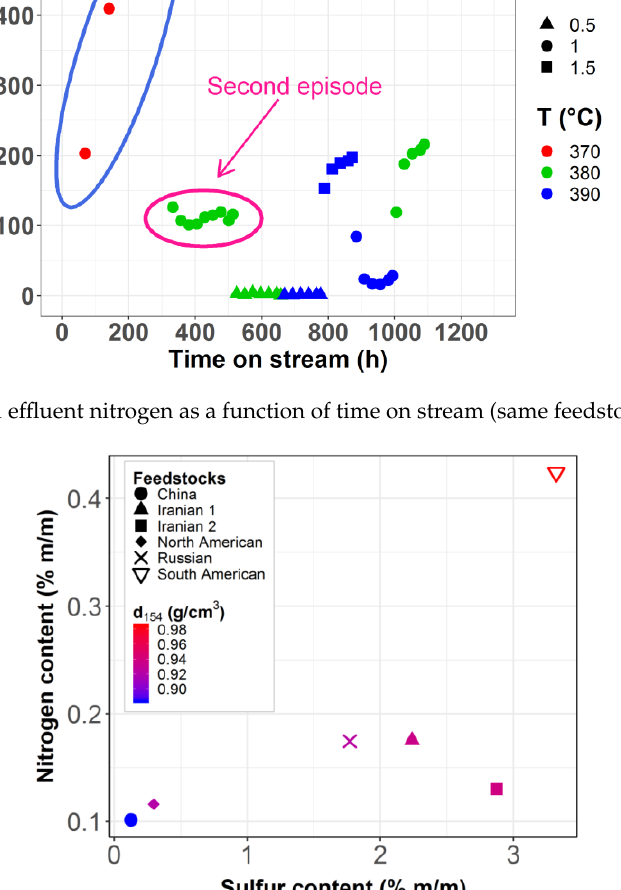
Figure 11. Sulfur, nitrogen content, and specific gravity at 15 °C for the feedstocks in the database.